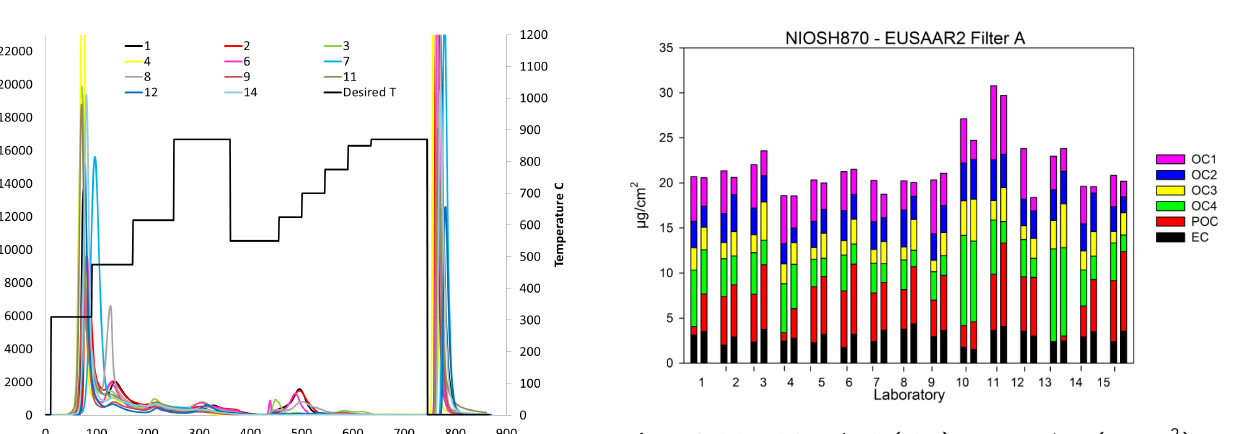
Figure 6. OC, POC and EC (TOT) concentrations (µgcm − 2 ) per temperature step and protocol for PM loaded quartz fibre filter (sam- ple A).